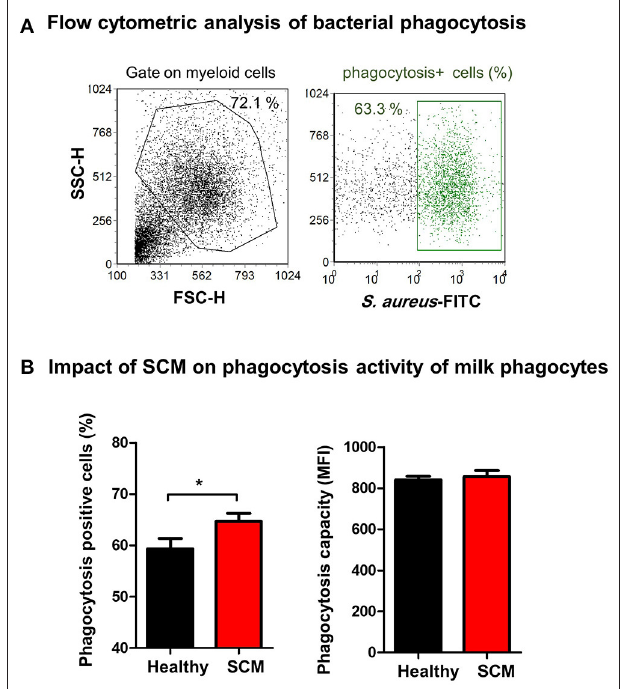
FIGURE 8 | (A) Separated milk cells were incubated with FITC-conjugated S. aureus and the fraction of phagocytosis-positive cells within the myeloid cell population (including granulocytes and macrophages defined based on SCG/SSC properties) was estimated by flow cytometry based on their enhanced fluorescence in the green fluorescence channel. (B) The percentage of phagocytosis-positive cells and their mean fluorescence intensity (MFI), which is a metric of phagocytic capacity of the cells, were calculated and presented for healthy and SCM